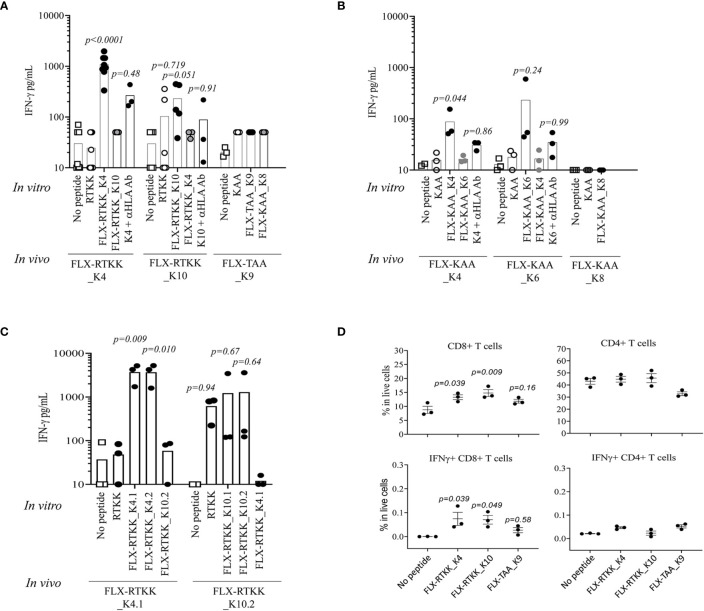
Immunogenicity potential of flucloxacillin (FLX)-haptenated peptide is dependent on the peptide sequence, the position of the lysine to which drug is conjugated and the expression of human leukocyte antigen (HLA). (A, B) Tg/KO mice (n=3–9) were immunized by 2 s.c. doses of 100 μg of FLX-peptides together with 150 μg of HBV128-140 CD4+ T helper peptide with IFA. Splenocytes were subsequently stimulated in vitro with 10 μg/ml peptides (as indicated) for 5 days. IFN-γ was measured in the supernatant of the cultures by ELISA. In vitro responses to the in vivo immunogen were blocked by anti-HLA B/C antibody. (C) Immunizations and cultures were set up similarly to that described in A but with peptide isoforms of the FLX-RTKK peptides. (D) IFN-γ intracellular staining of day 5 splenic cell cultures from animals treated with FLX-peptides and stimulated in vitro with the same peptide. Graphs show results gated in CD8+ or CD4+ T cell populations (one representative of two experiments). Statistical analysis by one-way ANOVA using the no peptide condition as baseline. p-values are only shown if <0.999.